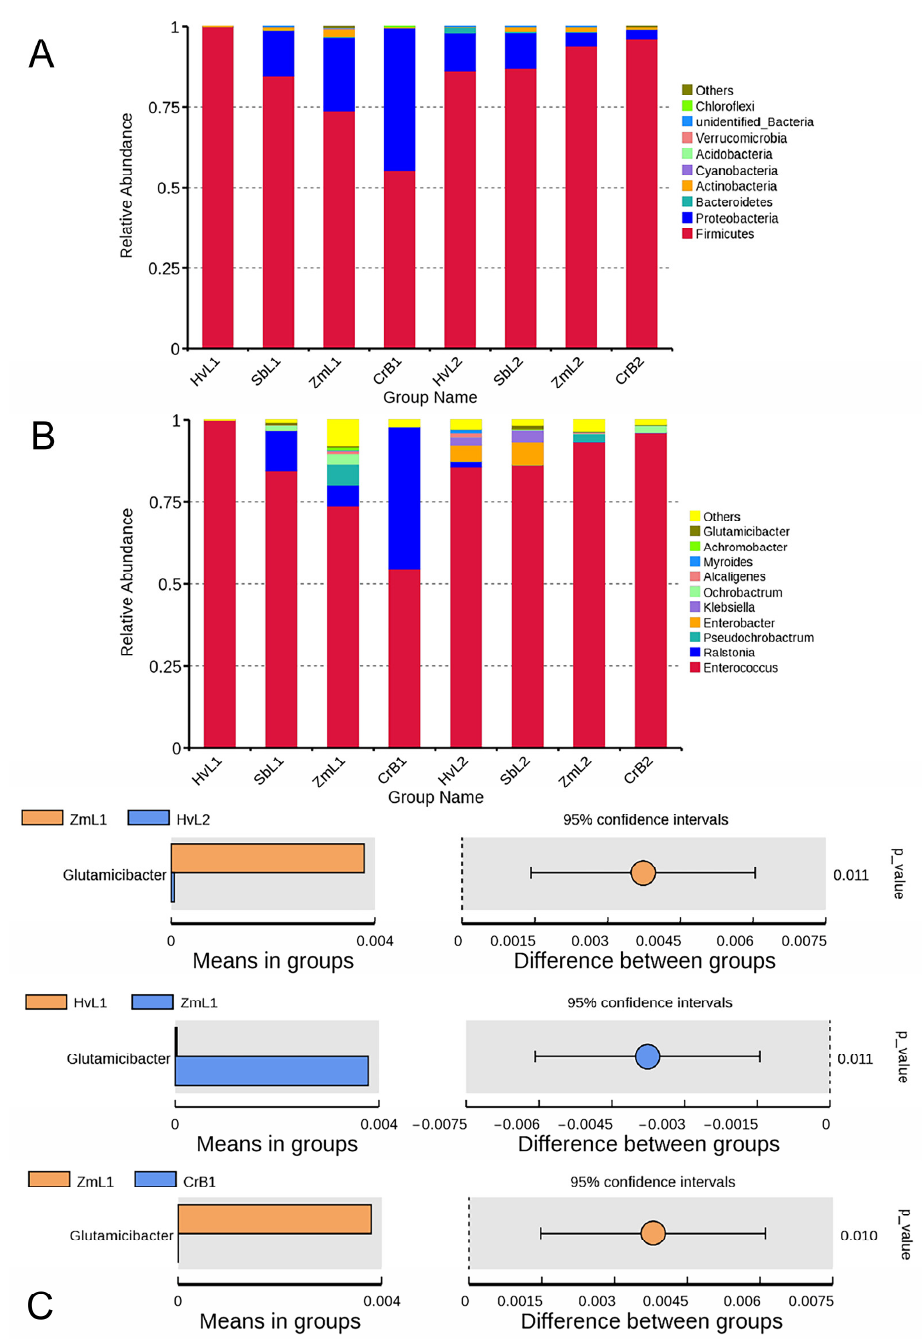
Figure 2. Relative abundance of the most predominant taxa of gut bacteria in S. frugiperda larvae fed on leaves of different host plants at the ( A ) phyla and ( B ) genera levels. ( C ) T -test analysis of species differences between groups. Others represents the sum of the relative abundances of all phyla (genera) other than the phyla (genera) in the figure. Each bar in the figure represents the mean value of species with significant differences in abundance between groups. It is the p -value for the between-group significance test for the corresponding differing species.